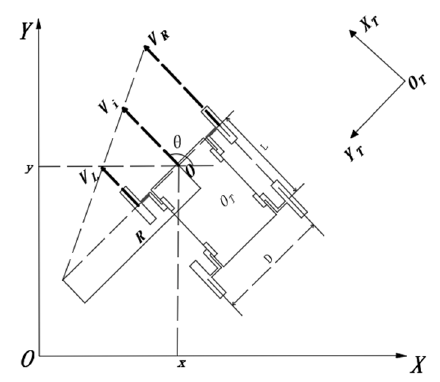
Figure 4. Small radius turning process.